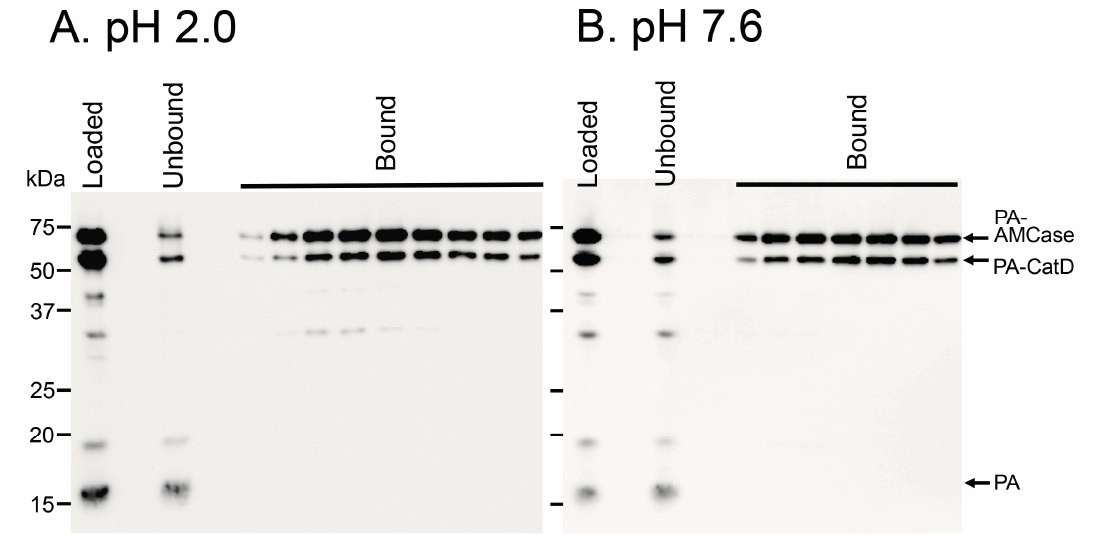
Figure 4. Affinity of Protein A-CatD-V5-His to chitin beads. Protein A-AMCase-V5-His, Protein A-CatD-V5-His and Protein A-V5-His were mixed and loaded onto chitin bead columns. Chitin binding assays were performed at pH 2.0 ( A ) or pH 7.6 ( B ) as described in the Experimental Section. The bound and unbound fractions were analyzed by Western blot using anti-V5-HRP